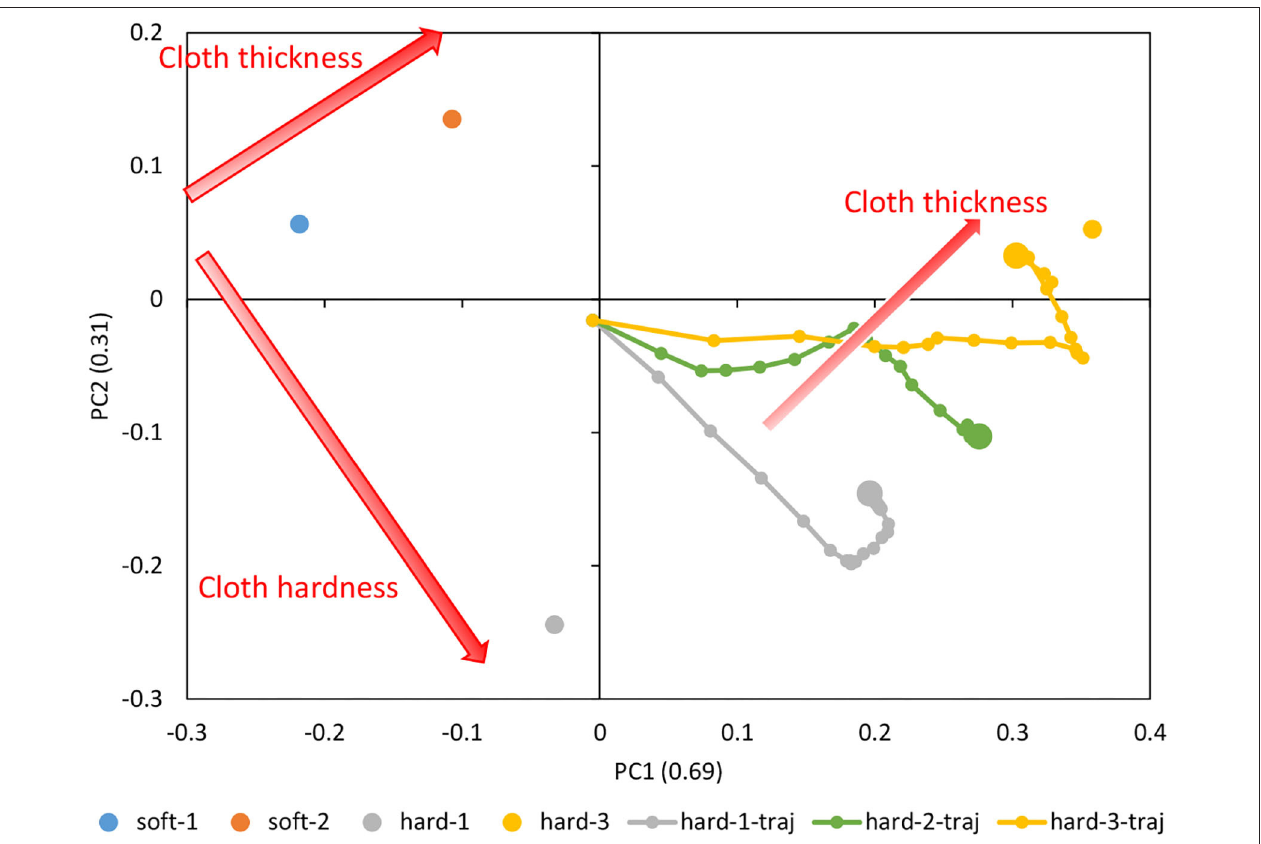
FIGURE 9 | Actual robot experiment: the trained parametric bias for soft-1, soft-2, hard-1, and hard-3, and the trajectory of online updated parametric bias for hard-1, hard-2, and hard-3.